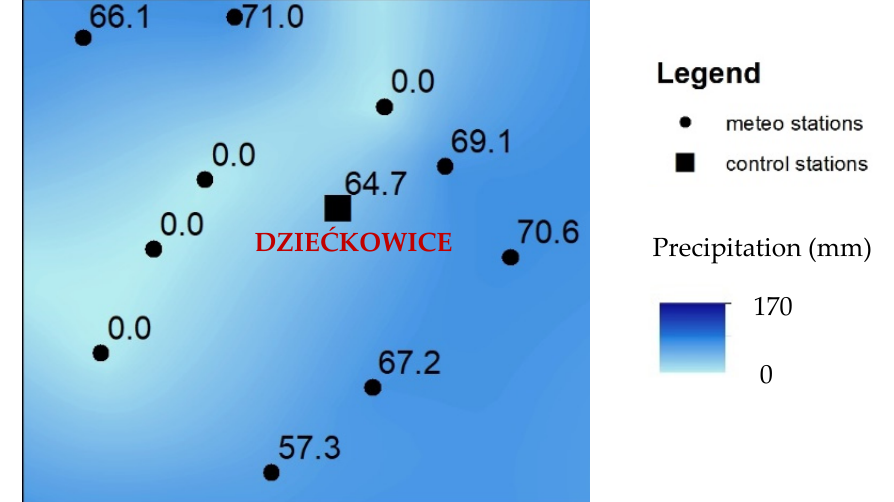
Figure 8. Explanation of disturbances in the measurements at the control station of Dzie ć kowice, January 2015. Part ( a ) presents localization of control station in Poland. The other parts show interpolation of SPI-1 with different methods: ( b ) Inverse Distance Weighted, ( c ) Natural Neighbor, ( d ) Linear method, ( e ) Kriging, ( f ) Splines.